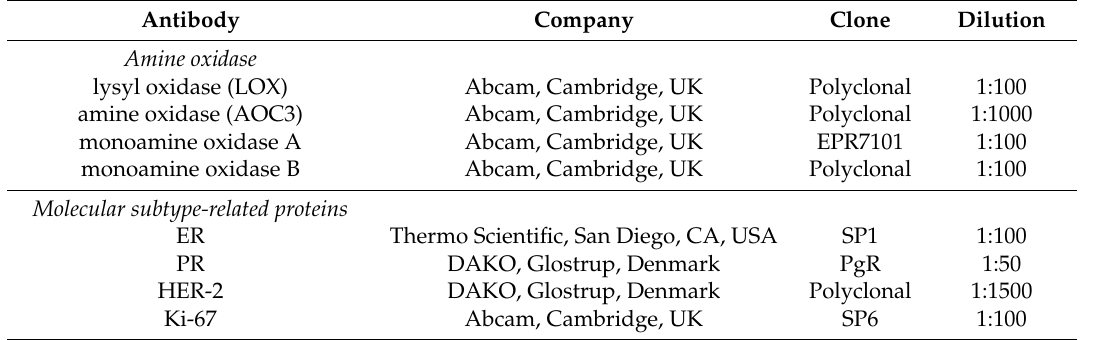
Table 5. Source, clone, and dilution of